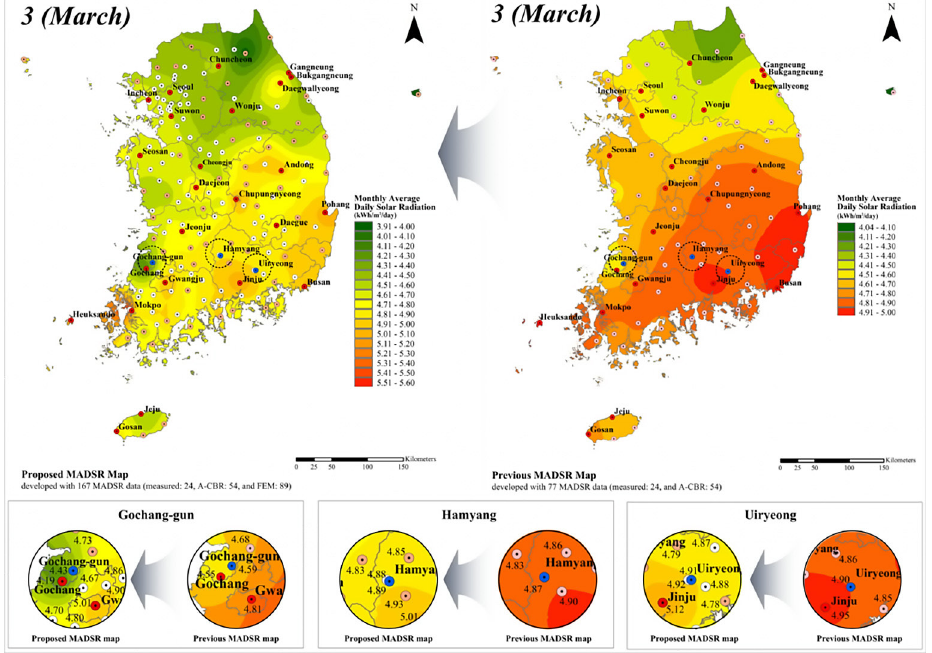
Fig. 8. Classification level of the proposed and previous MADSR maps (March in South